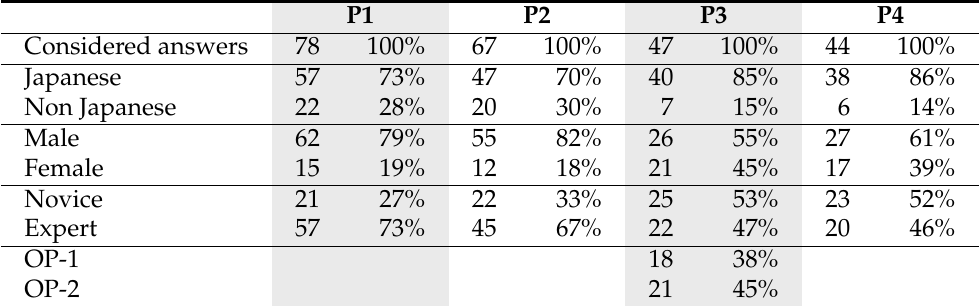
Figure 6. The content of each questionnaire P1–P4. The number in the red circle indicates the number of questions. Table 4. Demographic data of each questionnaire. Some participants did not mention their gender or country. For the latter, we assume they were Japanese or not depending on the version of the questionnaire they used (Japanese or